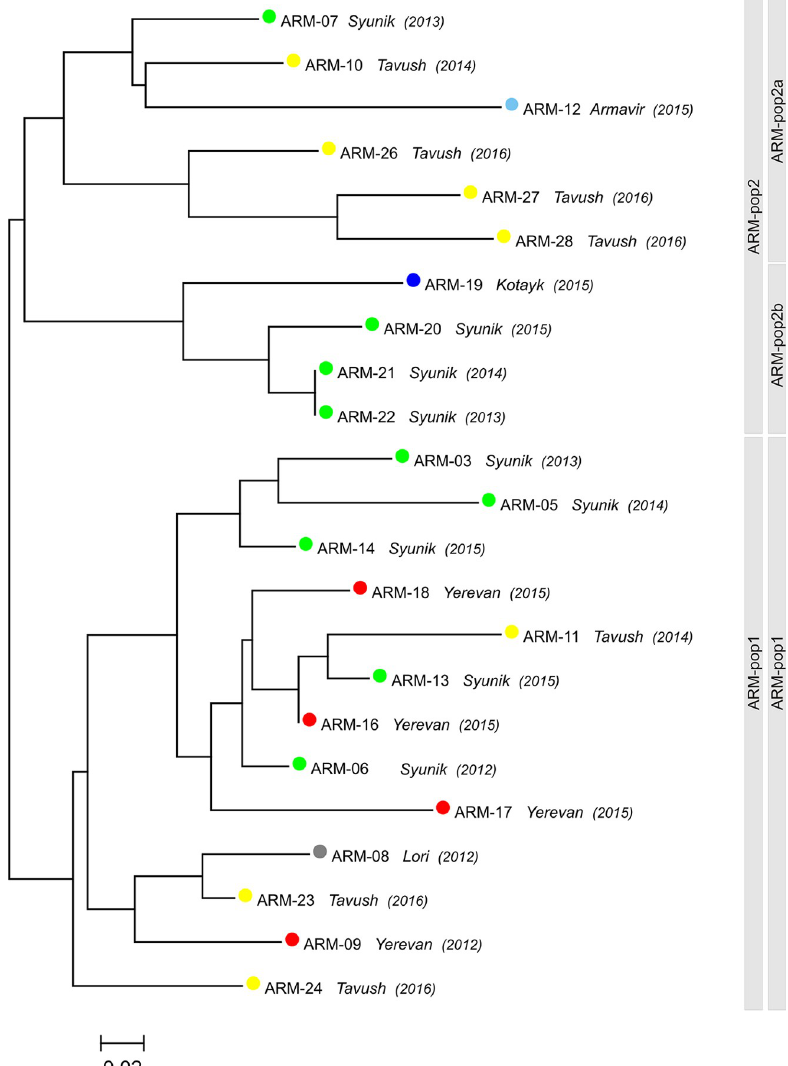
Fig 2. Diversity of genotypes of Leishmania infantum from clinical samples of 23 patients with visceral leishmaniasis. Samples are from active foci in six districts of Armenia (shown in Fig 1) marked by different colors. The year of occurrence of the infection is indicated in brackets. The neighbor joining tree is based on multilocus microsatellite typing with a standard set of 14 microsatellite markers specific for the Leishmania donovani complex. Populations as inferred by STRUCTURE are indicated by bars next to the tree. According to Δ K the most probable number of populations is two ( K = 2, left bar). In addition also the result of the analysis for substructures is shown (right bar). ARM-pop2a and ARM-pop2b are the two subpopulations inferred for population ARM-pop2. ARM-pop1 was not further divided into